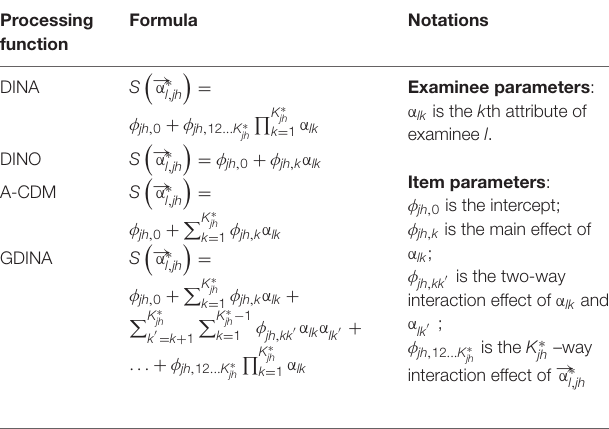
TABLE 1 | Summary of S( → α ∗ l , jh ) for different processing functions. Processing